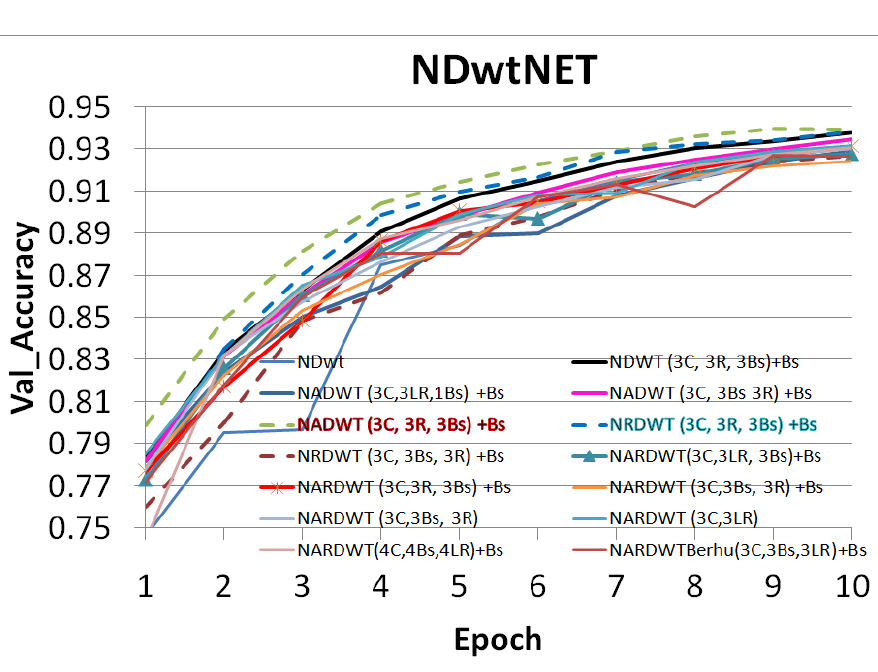
Figure 17. Model validation accuracy